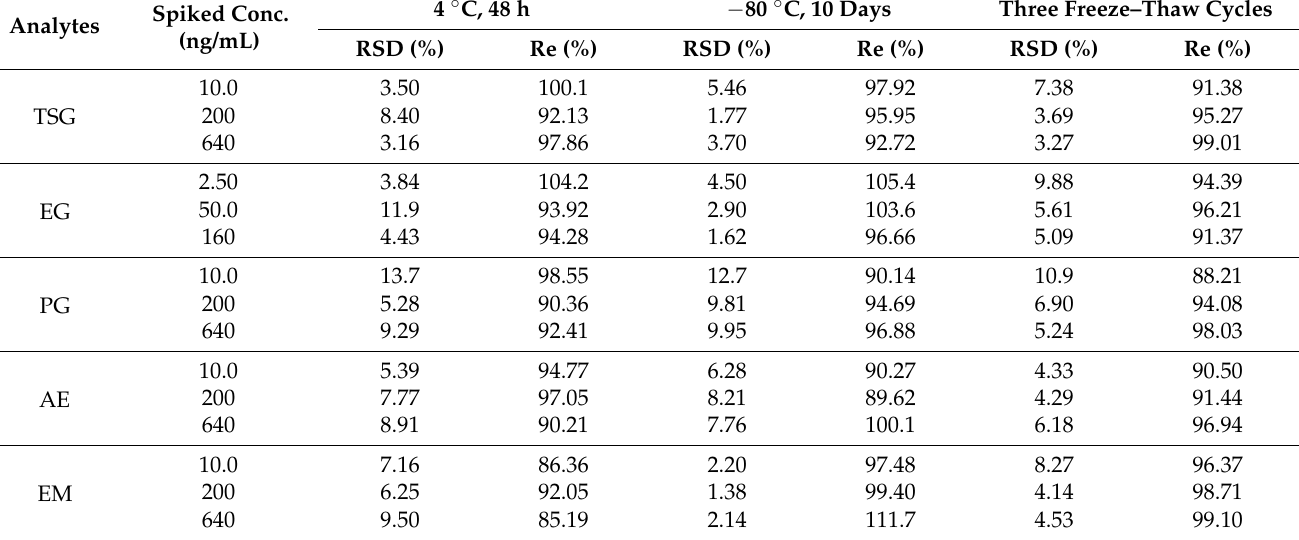
Table 4. Stability results of TSG, EG, PG, AE, and EM in rat plasma under different conditions ( n = 6). Spiked Analytes